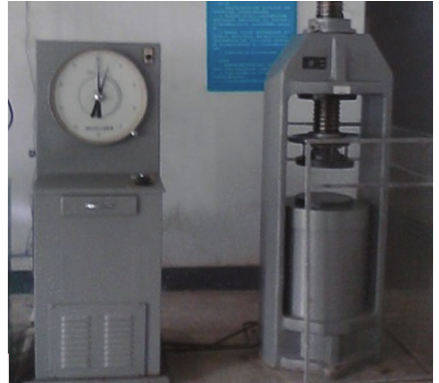
Figure 1: Compression testing machine 1 (2000 kN).